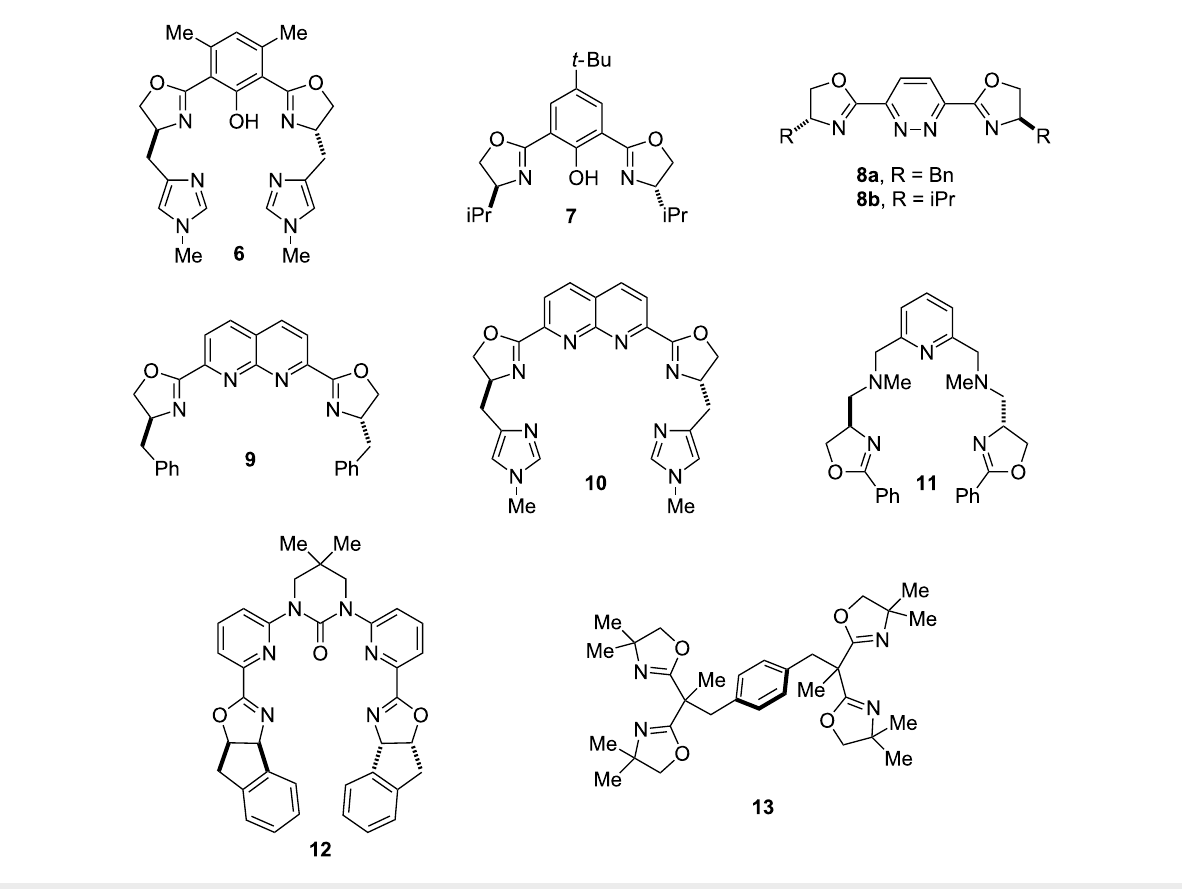
Figure 2: Previously reported bisoxazoline ligands capable of stabilizing bimetallic complexes.